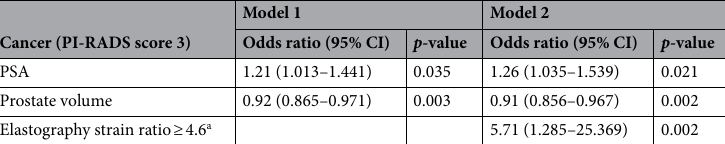
Table 4. Results of multivariable logistic regression analyses for predicting prostate cancer on prostate MRI- targeted biopsy of PI-RADS score 3 lesions. Data are presented as median (interquartile range). a Cut-off value of the elastography strain ratio for predicting prostate cancer using the Youden index. CI, confidence interval; MRI, magnetic resonance imaging; PI-RADS, Prostate Imaging Reporting and Data System; PSA, prostate- specific